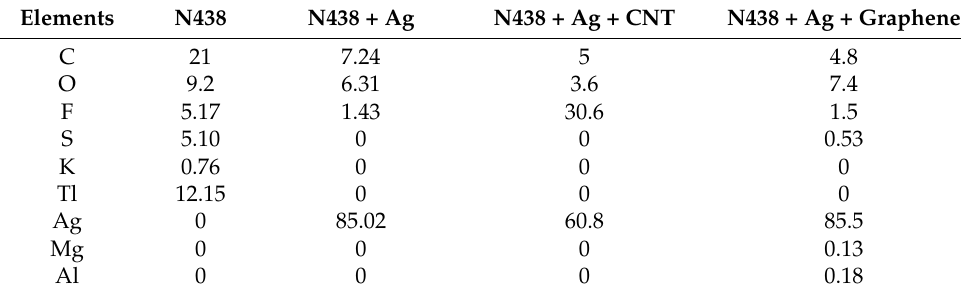
Figure 3. Elemental composition of ( a ) Nafion, ( b ) Nafion + Ag, ( c ) Nafion + Ag + CNT and ( d ) Nafion + Ag + Graphene. + Ag + Graphene. Table 2. Mass percentage of the elements for different samples. Table 2. Mass percentage of the elements for different